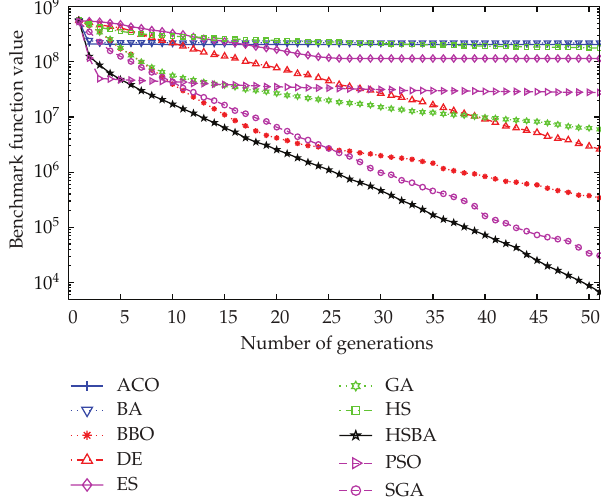
Figure 5: Comparison of the performance of the different methods for the F05 Penalty #2 function.